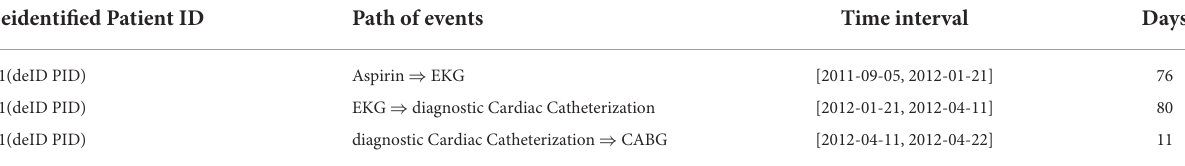
TABLE 2 Example of the time interval and days between pair of events for a patient. Deidentified Patient